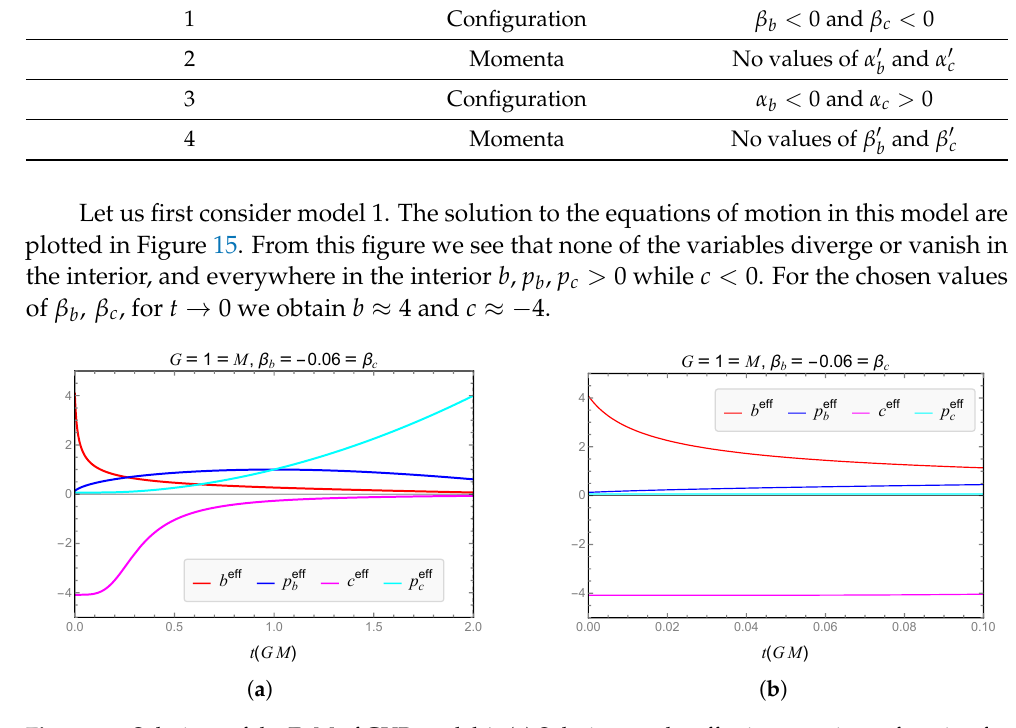
Table 1. Comparison of GUP models with regard to the possibility of singularity resolution. Dependence of GUP Expansion and RE Finite for Model Modifications on 1 Configuration